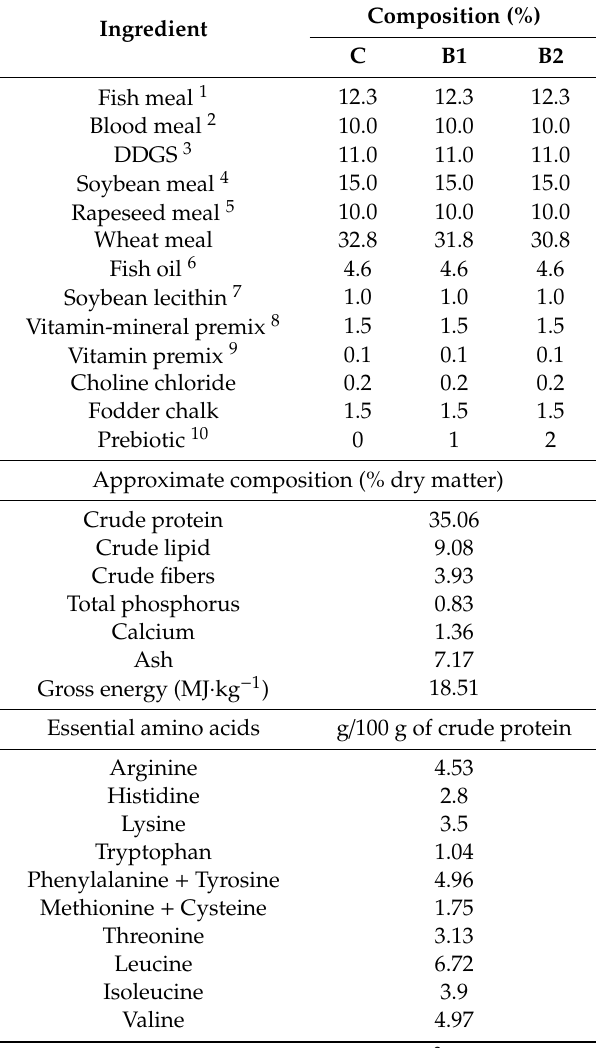
Table 1. Dietary formulation and calculated nutritive values of experimental